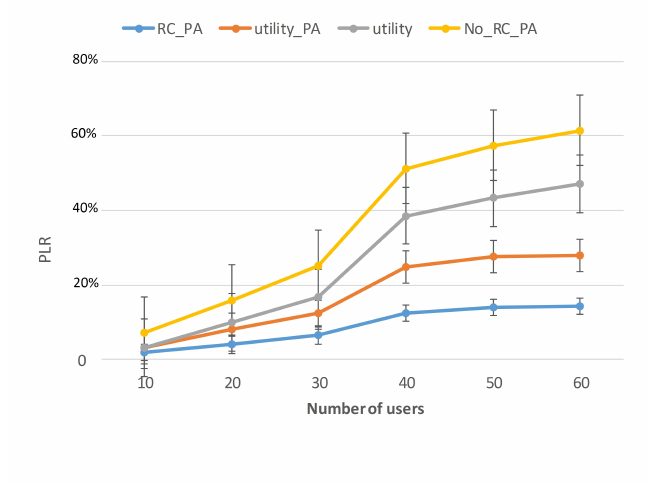
Figure 6. Packet loss ratio vs. number of